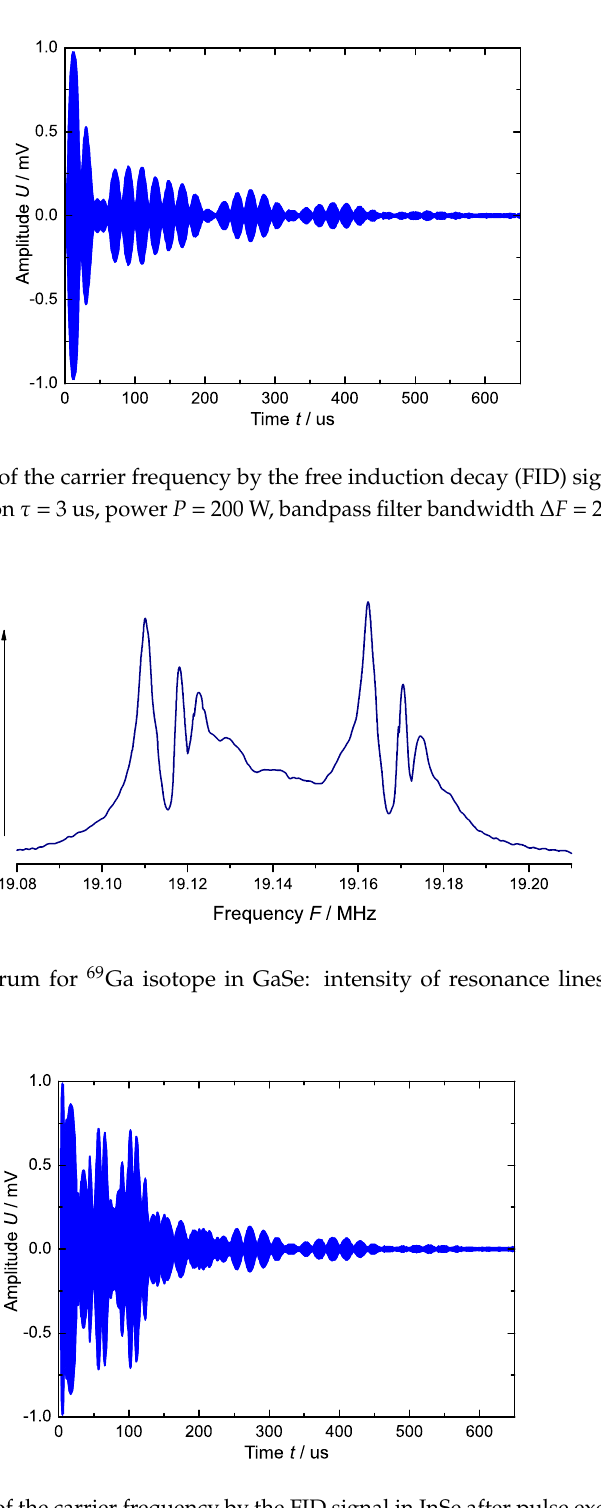
Figure 13. Modulation of the carrier frequency by the FID signal in InSe after pulse excitation (duration τ = 3 us, power P = 200 W, bandpass filter bandwidth Δ F = 25 MHz, blanking time τ BL ~300 ns).